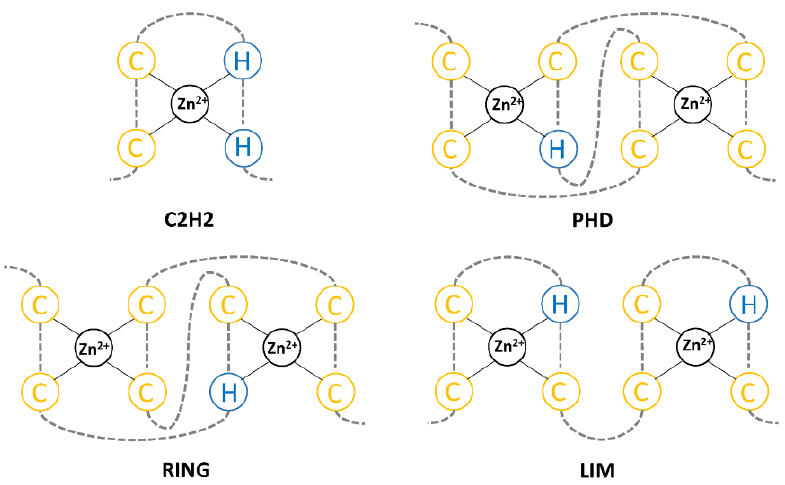
Figure 2. Scheme of C2H2, PHD, RING, and LIM zinc-finger domains.